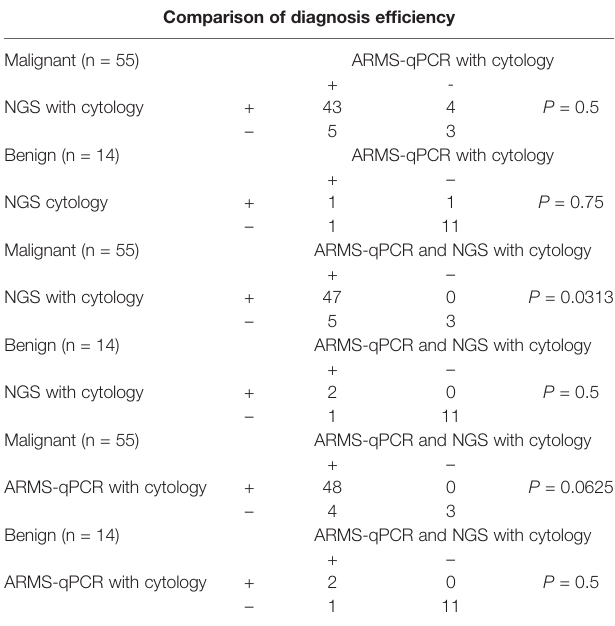
TABLE 6 | Comparison of diagnosis ef fi ciency of three combined diagnostic approaches. Comparison of diagnosis ef fi